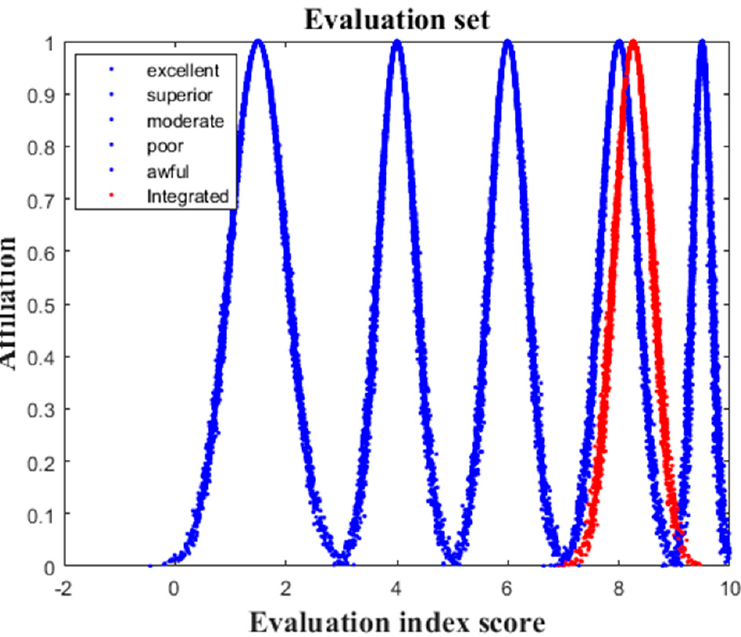
Figure 3. Integrated cloud model. The figure compares the generated integrated cloud model diagram with the standard cloud model diagram to judge the security level of the integrated cloud model. The red represents the integrated cloud model, and the blue represents the standard cloud